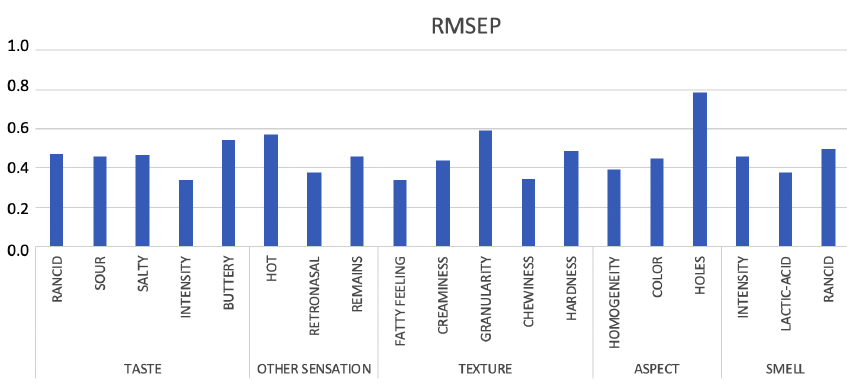
Figure 6. The root mean squared error of prediction for the whole set of parameters for unknown samples.